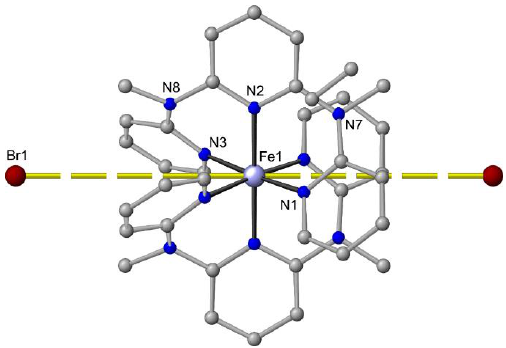
Figure 8. Molecular structure of mer -[Fe(ddpd) 2 ]Br 2 in the solid state; hydrogen atoms and solvent molecules omitted. Atom numbering unified for clarity. Fe … Br distances indicated by yellow dashed lines.